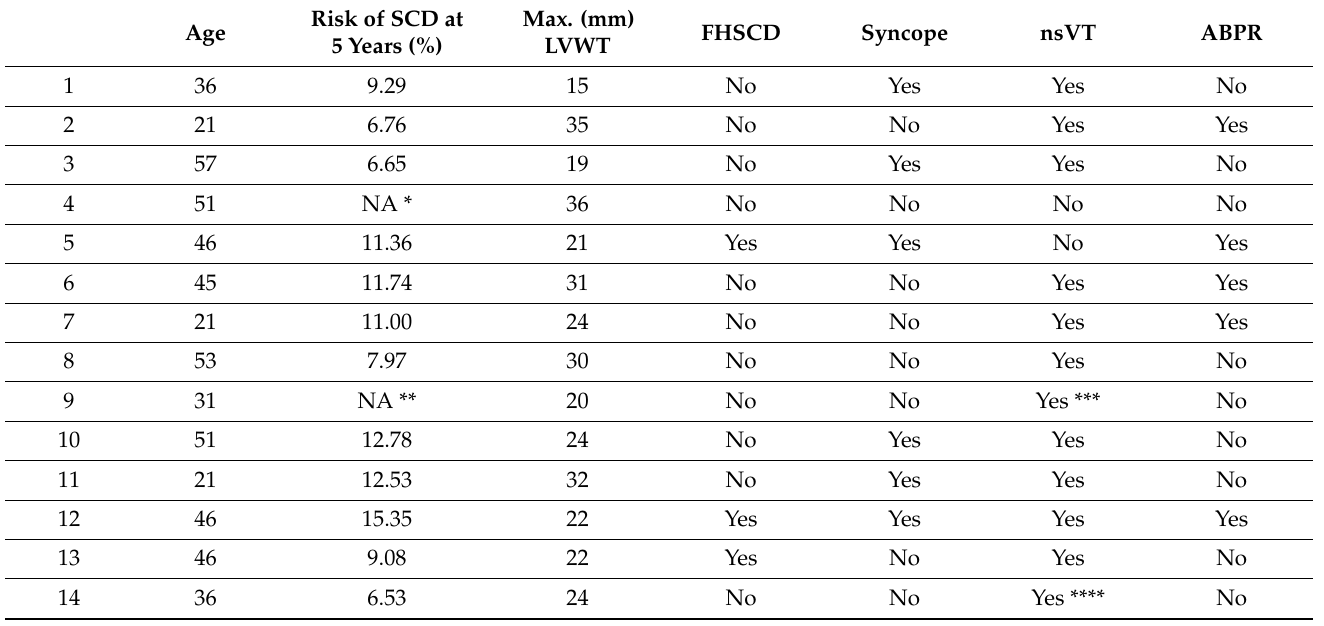
Table 1. Major risk factors and calculated risk of SCD at 5 years in patients with appropriate ICD intervention in a group of patients implanted with ICD for primary